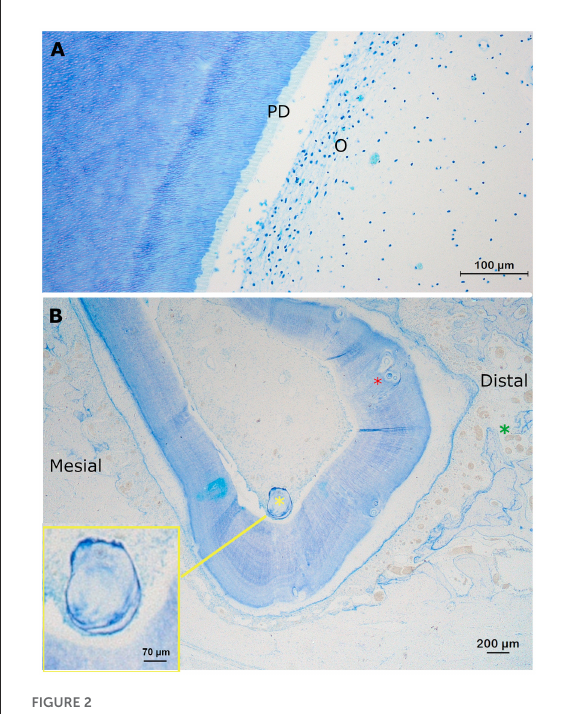
FIGURE2 Normal findings at the level of the pulp. (A) Transverse section at a mid-tooth level (10mm subocclusal) of pulp horn two in a first molar in the left lower jaw in a 3-years-old animal (dental age of 2 years and 4 months). A layer of odontoblasts (O) is visible in the periphery of the pulp. Due to shrinkage artifacts, the columnar morphology of the cells is not displayed very well. The predentin is clearly visible (light blue) (PD). At the border between the predentin and the mineralized dentin, globular structures are often visible indicating a mixture of linear and globular mineralization. More centrally, at the level of the pulp, blood vessels can be identified (Toluidin, 10x magnification). (B) A transverse decalcified section through root I of the left